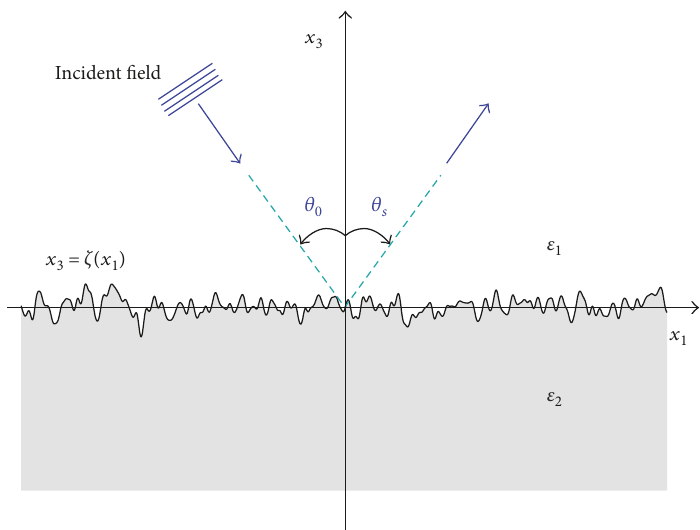
Figure 1: Schematics of the scattering